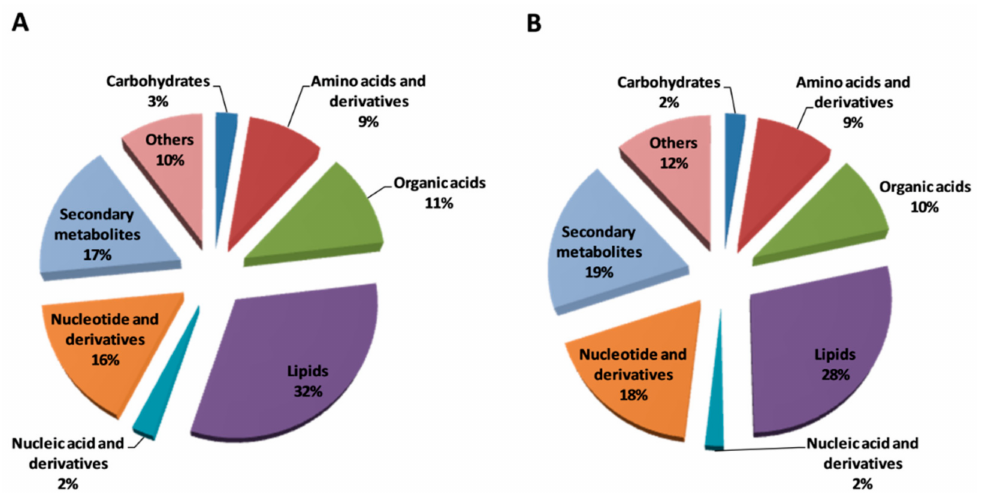
Figure 1. Functional classification of metabolites ( A ) pumpkin-grafted watermelon (PGW) ( B ) self- rooted watermelon